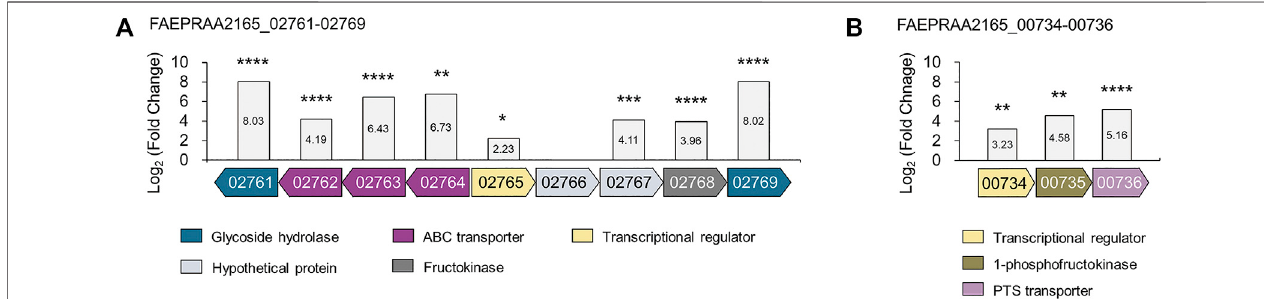
FIGURE 6 | The gene organization of proteins upregulated from proteomic analyses of F. prausnitzii grown on inulin relative to glucose. Proteins involved in (A) inulin-type fructan utilization and (B) fructose uptake were annotated. The locus tag numbers FAEPRAA2165_XXXXX are abbreviated with the last numbers after the hyphen. Proteins with similar predictedfunctions are colored bythe same color. The log 2 (fold-change) relativeto F. prausnitzii grown on glucoseisshown on the y -axis. The proteomic analysis was performed in triplicates. * p < 0.05, ** p < 0.01, *** p < 0.001, **** p < 0.0001., Protein annotation: β -fructosidase (02761); fructan ABC transporters (02762 – 02764); LacI family transcriptional regulator (02765); hypothetical proteins (02766 – 02767); fructokinase (02768); amylosucrase (02769); DeoR family transcriptional regulator (00734); 1-phosphofructokinase (00735); fructose PTS transporter (00736).